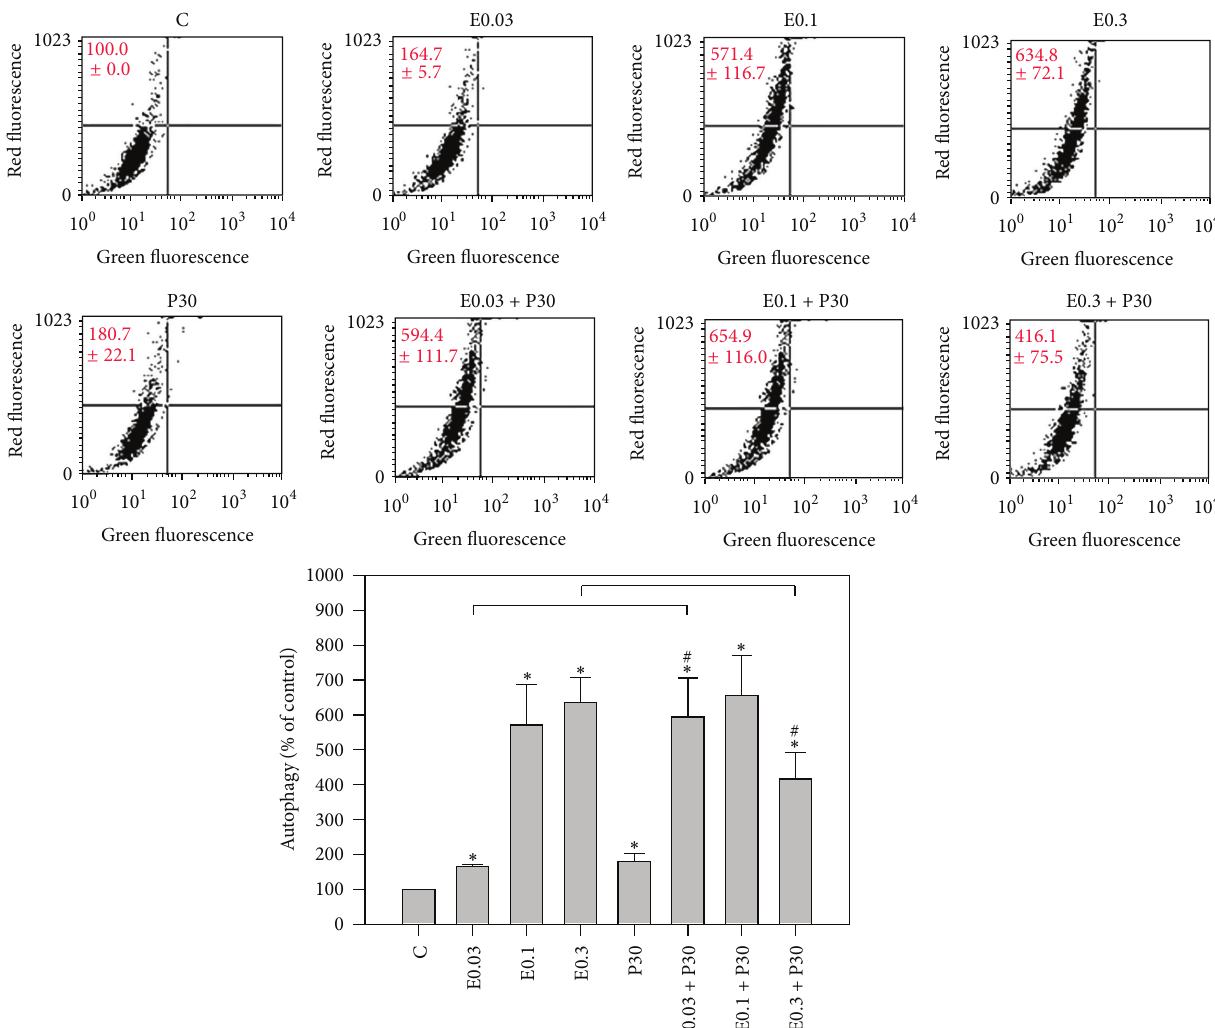
Figure4:Epirubicinand/orprogesteroneeffectonautophagyinduction.HA22T/VGHcellsweretreatedwithepirubicinand/orprogesterone for 24 h then stained with acridine orange and followed by flow cytometric analysis of autophagy. Results are expressed as the mean ± standard deviation (S.D.) for three separate experiments. C: untreated cells, E0.03: 0.03 𝜇 M epirubicin, E0.1: 0.1 𝜇 M epirubicin, E0.3: 0.3 𝜇 M